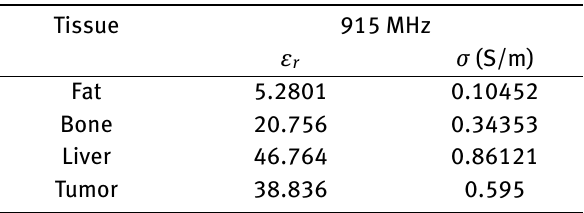
Table 3: Dielectric properties of human tissue and cancer at 915 MHz